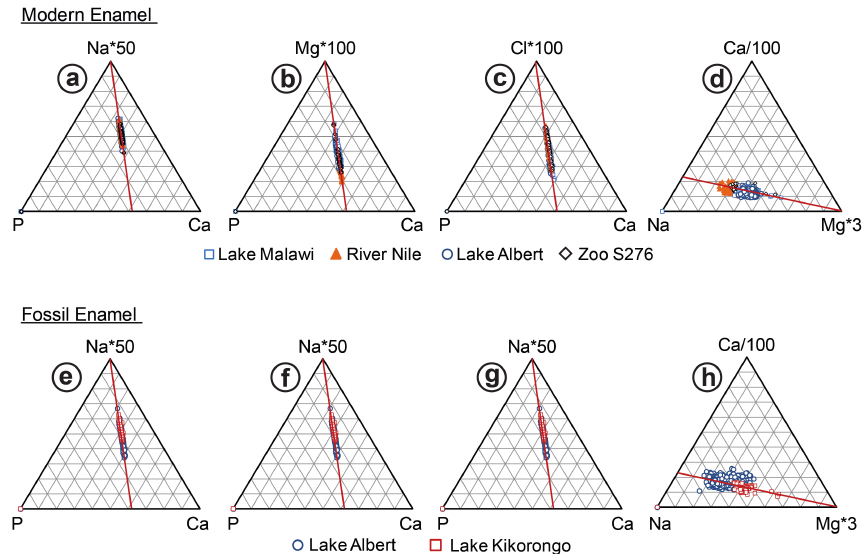
Fig. 7. Triangular diagram of chemical components (atomic proportions) in enamel of modern and fossil Hippopotamid molar teeth. Red line defines trend of constant P/Ca ratio observed in modern enamel. Modern and fossil enamel have identical P/Ca and display similar variations in Na, Mg, Cl, but variable Mg/Ca and Na/Mg. (a–d) : distribution of Na*50-Ca-P, MgO*100-Ca-P, Cl*100-Ca-P,Ca/100-Mg*3- Na respectively, in modern enamel (e–h) : distribution of Na*50-Ca-P, MgO*100-Ca-P, Cl*100-Ca-P,Ca/100-Mg*3-Na, respectively, in fossil